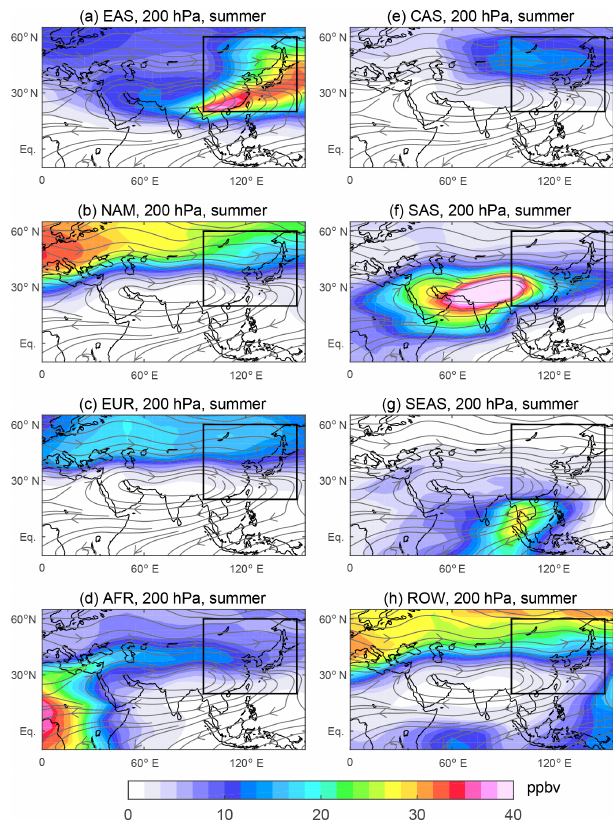
Figure 11. Horizontal distributions of ozone produced in differ- ent regions overlaid with streamlines in the upper troposphere (200hPa) in the summer of 2005. The boxed area indicates East Asia. The abbreviations are for (a) East Asia (EAS), (b) North America (NAM), (c) Europe (EUR), (d) Africa (AFR), (e) central Asia (CAS), (f) South Asia (SAS), (g) South-east Asia (SEAS), and (h) the rest of the world